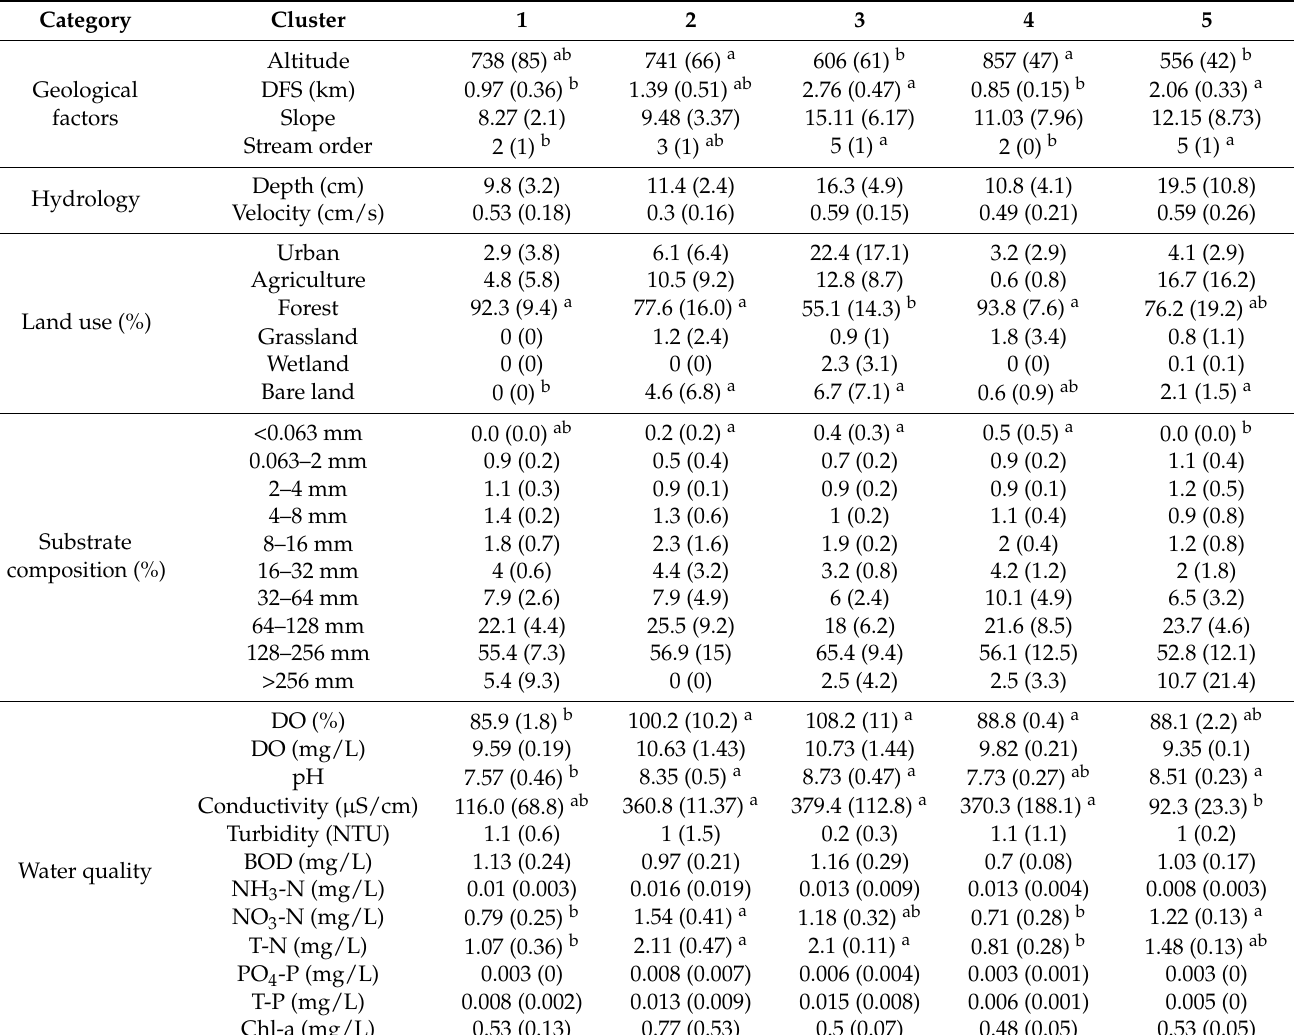
Table 4. Differences in environmental factors between five clusters in self-organizing